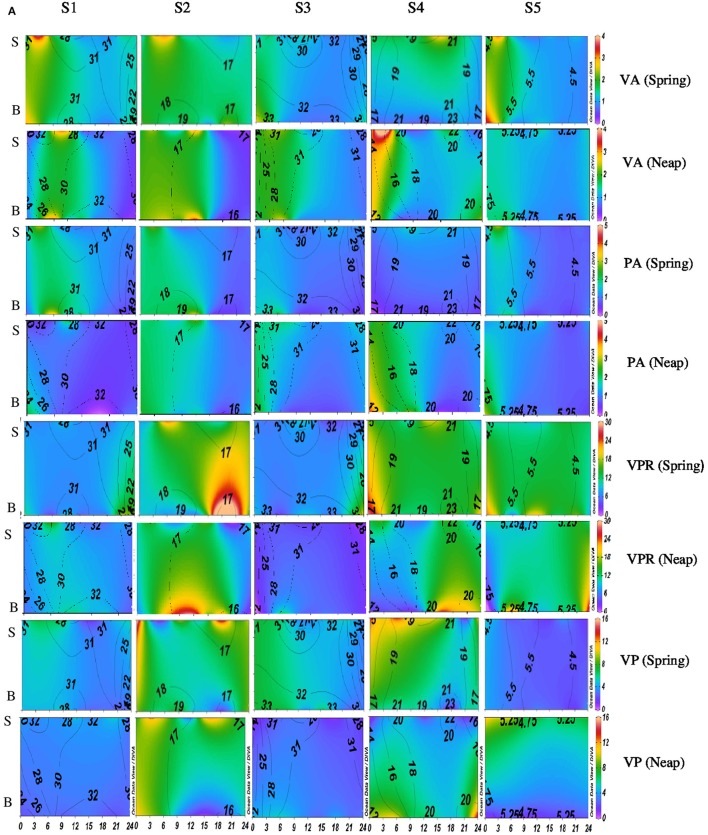
Temporal variations (diel and tidal) in biological parameters during pre-monsoon (PRM) in CE. X- axis represents the time series observations from 00:00 to 24:00 h and Y-axis represent the vertical section of the water column (S, Surface; B, Bottom). Z-axis represent different parameters in color contours and salinity is superimposed as the line contours. The vertical panels S1, S2, S3, S4, and S5 represents the five stations. The horizontal panels represent various parameters during PRM, such as viral abundance (VA) (106 VLPs mL−1), prokaryotic abundance (PA) (106 Cells mL−1), virus-to-prokaryote ratio (VPR), and viral production (VP) (1010 VLPs L−1day−1), during spring and neap phases separately.